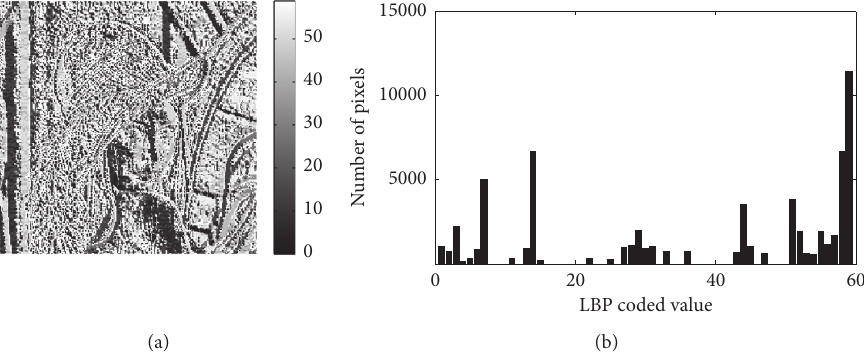
Figure 3: Uniform LBP spectrum and statistical histogram of Lena image. (a) Uniform LBP spectrum of Lena image. (b) Uniform LBP statistical histogram of Lena image.